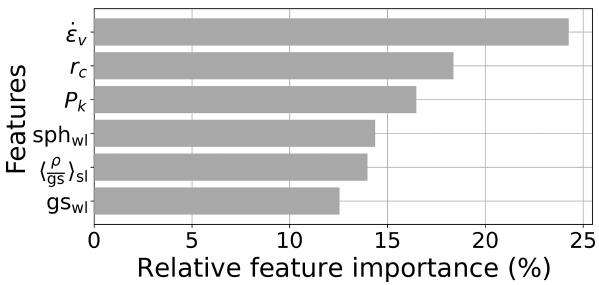
Figure 6. Feature importance ranking for the final model, based on evaluating the Gini impurity decrease at each split for every tree in the RF. The most important features were viscous deforma- tion rate ( ˙ (cid:15) v ), critical cut length ( r c ), skier penetration depth ( P k ), sphericity of grains in the weak layer (sph wl ), mean of the ratio (cid:105) of density and grain size of the slab ( (cid:104) ρ sl ), and weak layer grain gs size (gs wl ). For further details on these features, see Appendix B (Table